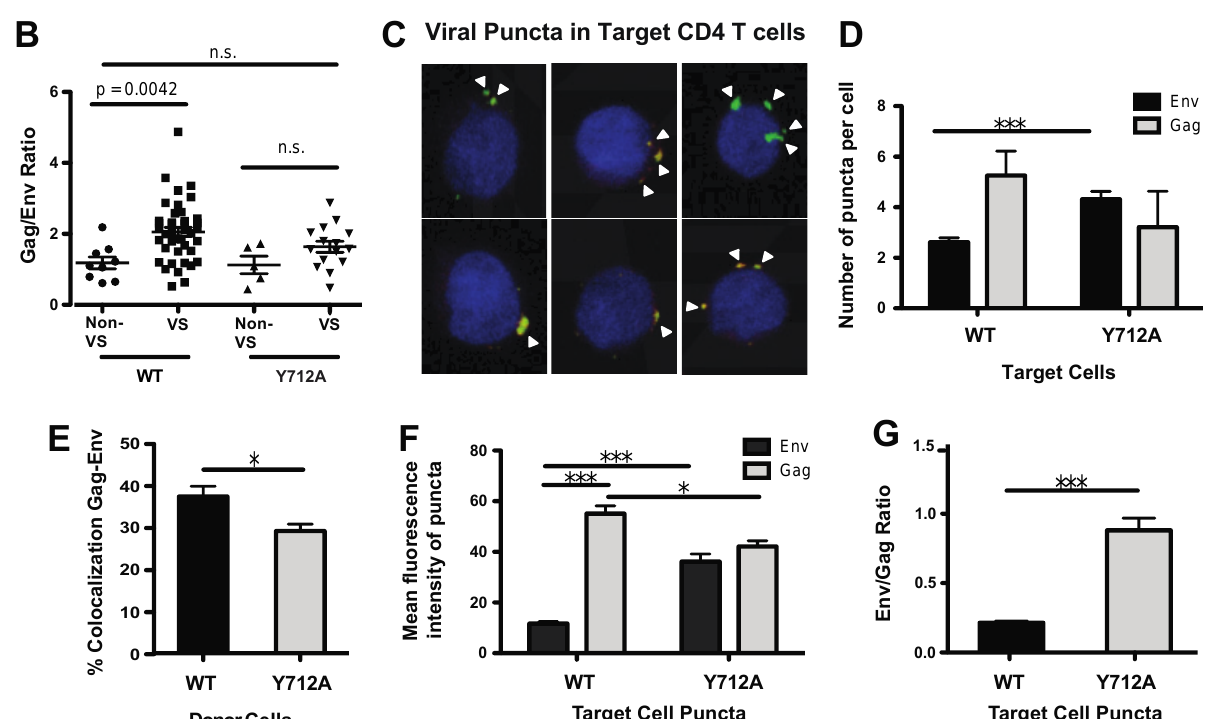
Figure 5. Measuring the influence of Env Y712A on the coordinated movement of Gag and Env during HIV cell–cell trans-